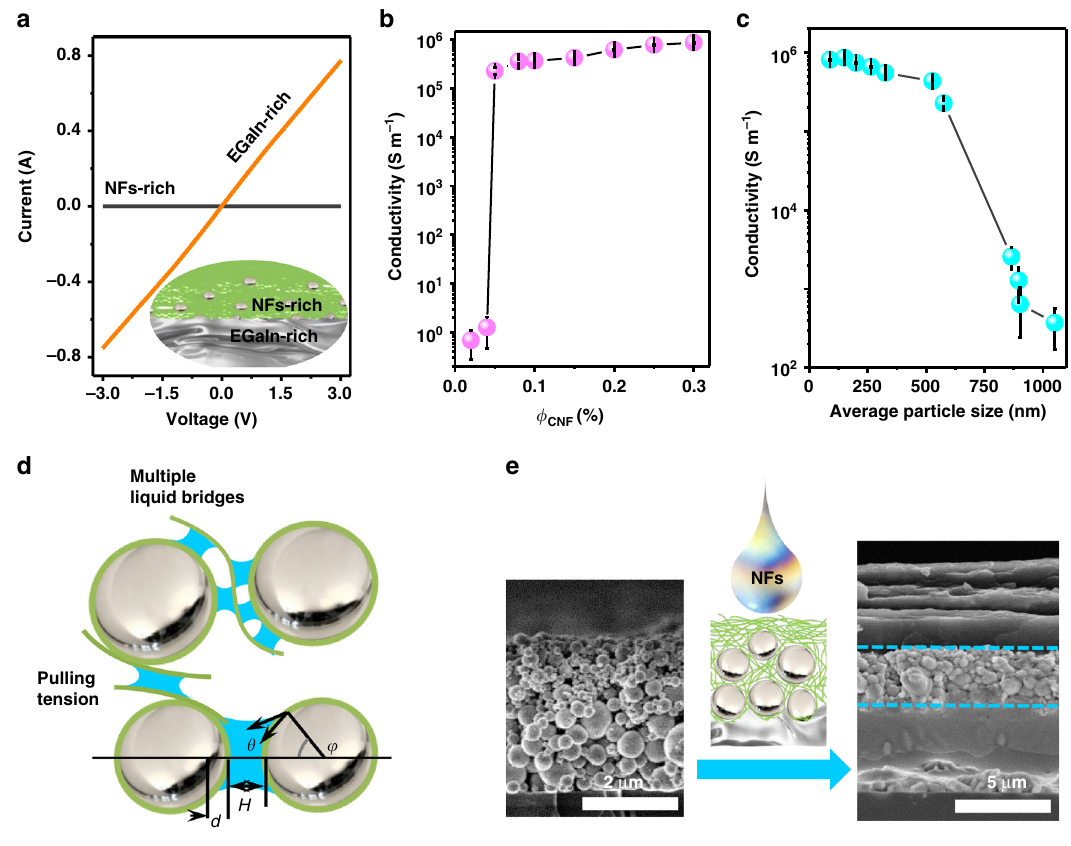
Fig. 5 Evaporation-induced sintering mechanism of EGaIn droplets with biological NFs. a I – V curves of CNFs-rich and EGaIn-rich sides of free-standing fi lms. EGaIn/CNFs layer thickness: 9/10 μ m/ μ m. b Effect of CNFs concentration on evaporation-induced sintering evaluated by conductivity of EGaIn-rich side. Average EGaIn droplet size: ~120 nm. c Size effect of EGaIn droplets on evaporation-induced sintering evaluated by conductivity of EGaIn-rich side. d Schematic illustration of sintering mechanism: Capillary force promoted by biological NFs; Local pulling tension induced by biological NFs; Splitting into multiple liquid bridges. e Depositing NFs suspension on layer of EGaIn droplets produced without NFs for evaporation-induced